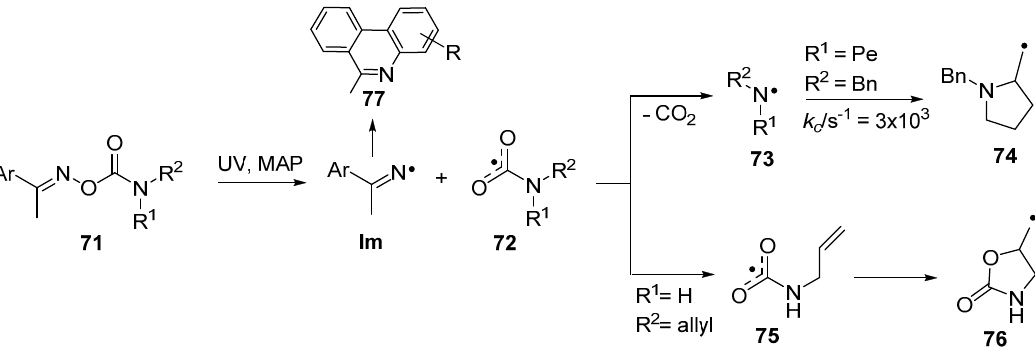
Scheme 11. Photochemical reactions of oxime carbamates